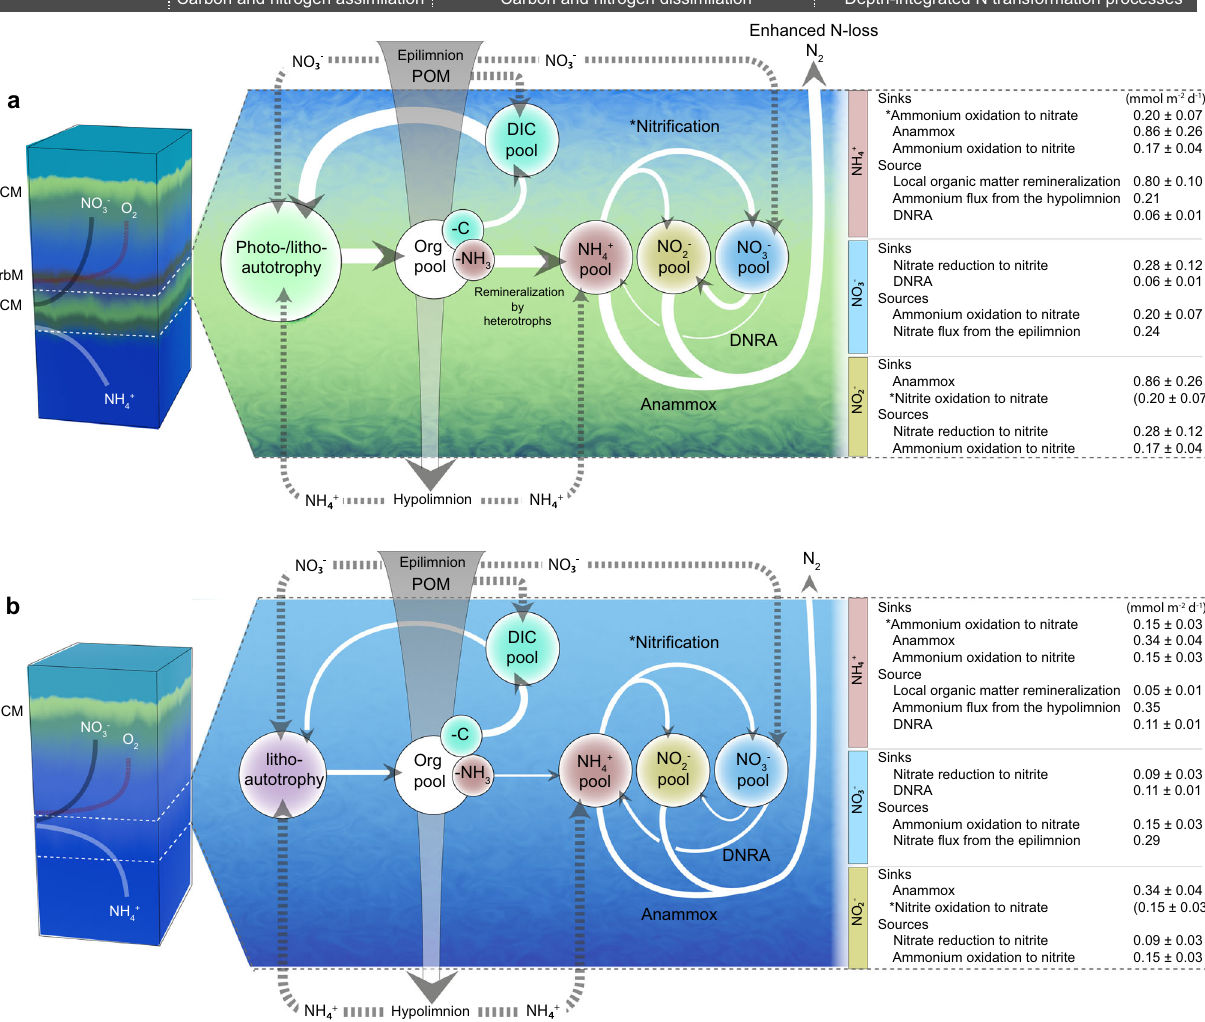
lines, while solid lines indicate rate transformation measurements, the size of the arrows re fl ect the depth-integrated values (in mmolm − 2 d − 1 ) in the adjacent panel. Depth-integrations were performed from the top of the anoxic zone (1 μ M O 2 ) down to 180 m depth (Fig. 2), with error values representing the asterisk), these measurements do not speci fi cally imply that comammox (i.e., complete nitri fi cation by a single organism 76 ) was involved. In the nitrate budget, we assume that the rate of nitrite oxidation to nitrate (indicated by the asterisk) would be equivalent or similar to the rate of ammonium